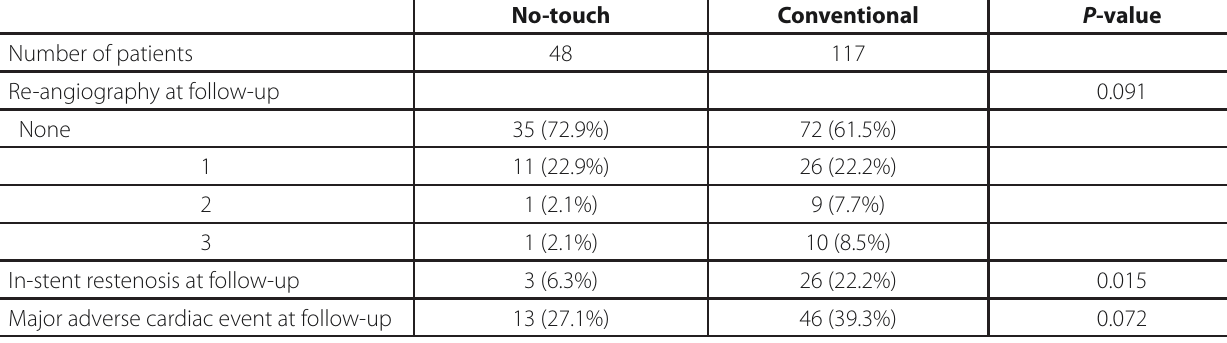
Table 4. Cardiac events at health-related quality of life